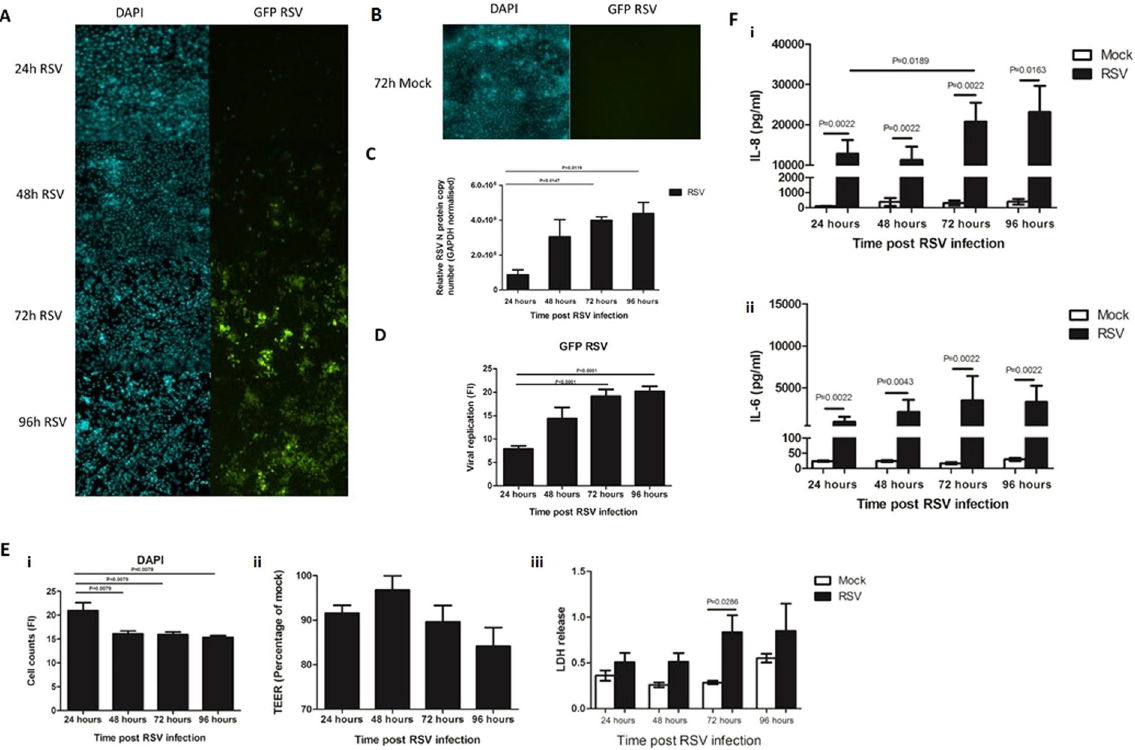
Figure 2. Characterisation of our RSV infection model. (A) Representative microscopy images of RSV infected A549 epithelial monolayer with green fluorescence (GFP) and DAPI fluorescence over time. (B) Representative microscopy images of mock infected A549 monolayer with GFP and DAPI fluorescence at 72 h post infection. No GFP fluorescence is observed in these controls. (C) Quantitative analysis of the images shown in Fig. 2A. GFP and DAPI fluorescence intensity was quantified using ImageJ, at least 4 images were used for each time point. Bars show mean ± SEM. Statistical significance is shown. (D) Quantitative RT-PCR of RSV viral load in A549 cells as measured by N protein copy number. Viral load was measure in A549 cells infected with GFP RSV over time. Bars show mean ± SEM of n = 3 biological repeats. Statistical significance is shown. (E) The damage caused to the A549 epithelium following RSV infection for 24, 48, 72 and 96 hours as determined by (i) number of epithelial nuclei/cell remaining attached to the membrane based on DAPI staining/0.045mm 2 (ii) TEER as measured using a voltohmmeter, data is represented as the percentage relative to the mock infected control (iii) Lactate dehydrogenase (LDH) release as measured in supernatant of AECs post RSV infection. Statistical significance is shown. Bars show mean ± SEM of at least n = 3 biological repeats. (F) CXCL8 (IL-8) and IL-6 concentrations in supernatants post RSV and mock infection of A549 cells as measured by ELISA. Bars show mean ± SEM of n = 3 biological repeats. Statistical significance is shown. For all other comparisons P >